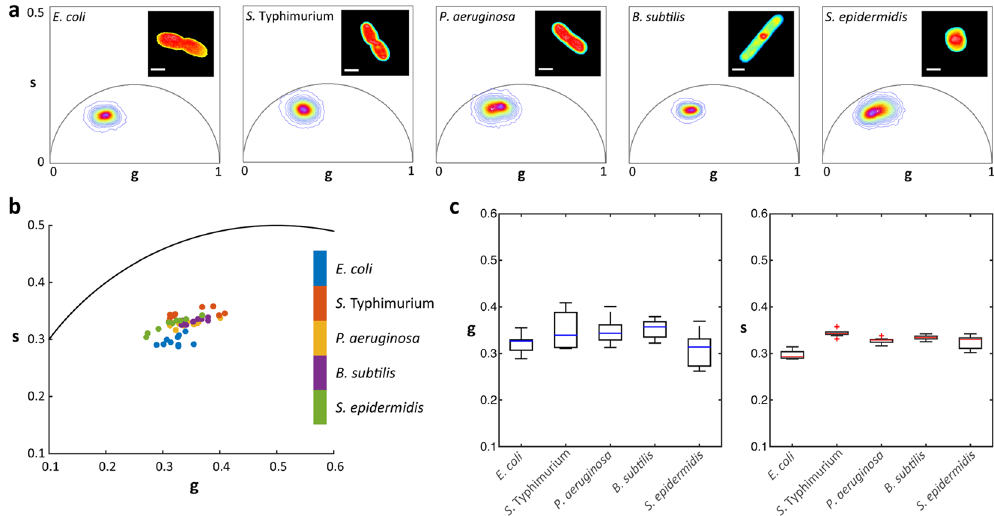
Figure 1. Bacterial phasor fingerprints. ( a ) Phasor distribution of E. coli, S . Typhimurium, P. aeruginosa , B. subtilis and S. epidermidis . Inset panels are representative fluorescence intensity images of each bacterium. ( b ) Bacterial phasor fingerprints of individual cells within each bacterial population. ( c ) Distribution of g and s within each bacterial population. Scale bars are 1 µ m.